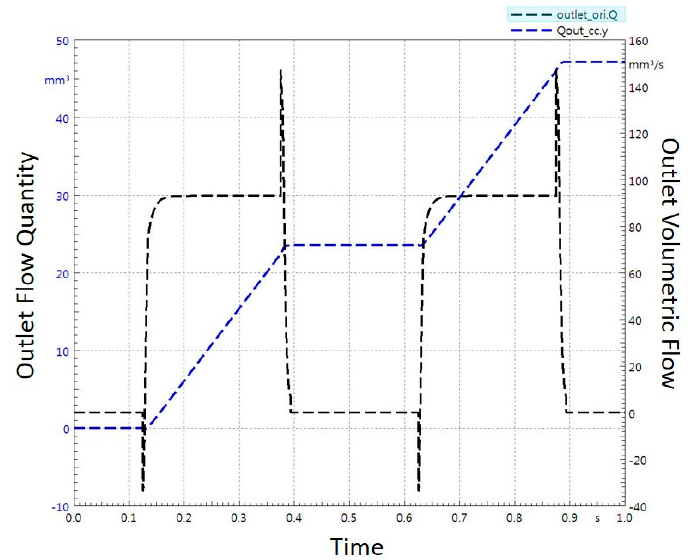
Figure 6. Plot of fluid volumetric flow rate and dispensed droplet volume with respect to open time.